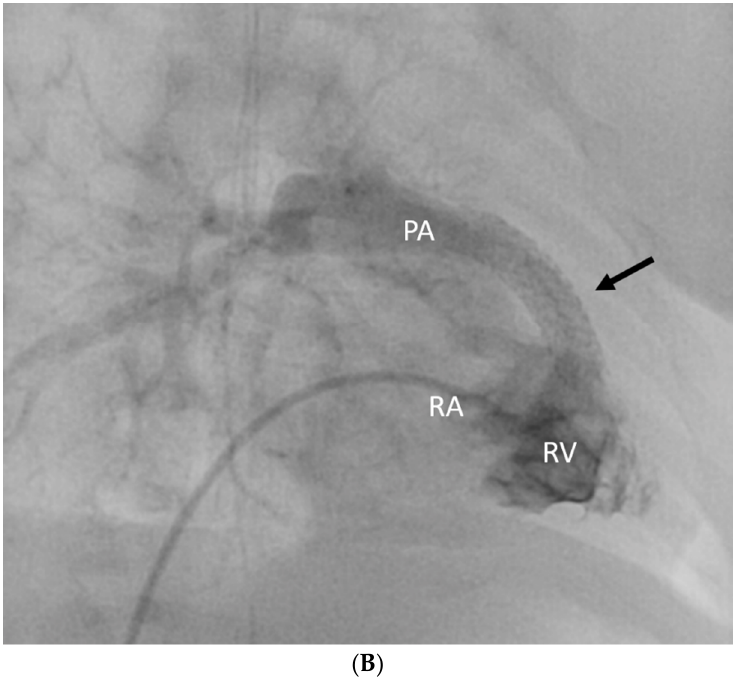
Figure 2. ( A ) Angiographic right anterior oblique view showing anterior deviation of the outlet septum and significant narrowing of the infundibular portion of the right ventricle. The black arrow indicates the narrow RVOT. ( B ) Significant increase of the pulmonary blood flow after RVOT stent angioplasty as imaged at the right anterior oblique view. The black arrow indicates the stented and enlarged RVOT. Abbreviations: RA = right atrium; RV = right ventricle; RVOT = right ventricular outflow tract; PA = pulmonary artery.